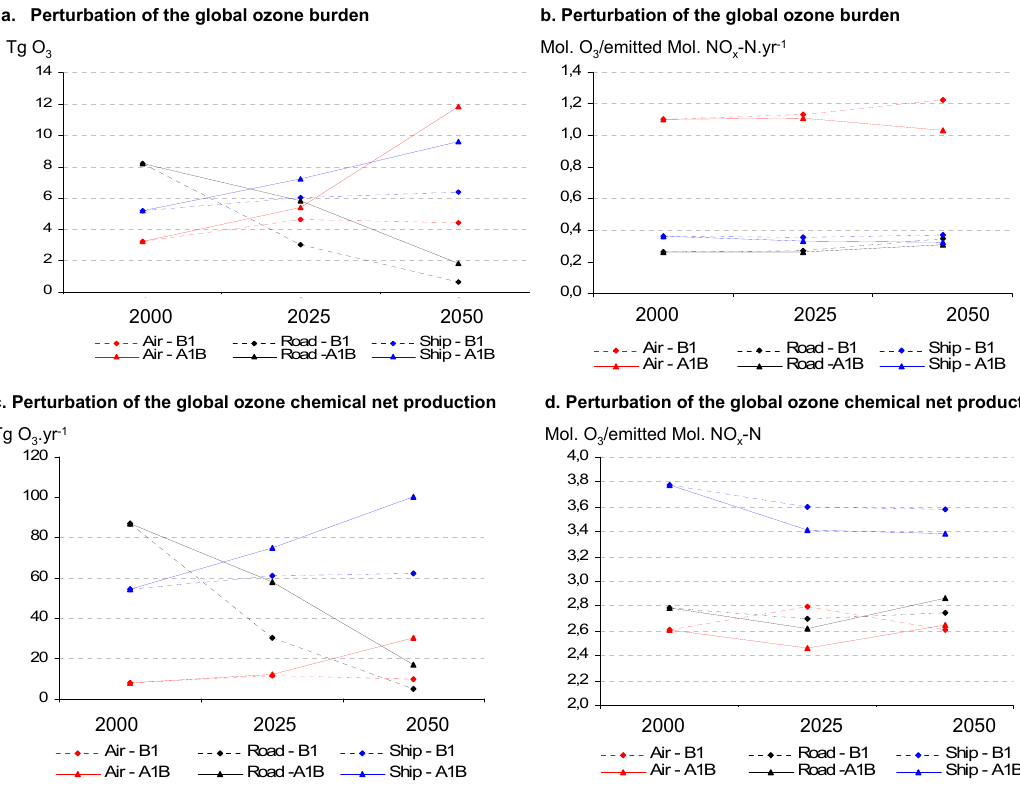
Fig. 7. Perturbation of the global ozone burden (a, b) and the global ozone chemical net production (c, d) due to 2000, 2025 and 2050 emissions from aircraft, road traffic and shipping. Both the absolute (left) and the relative (mol. O 3 per mol. of emitted NO x ; right) perturbations are